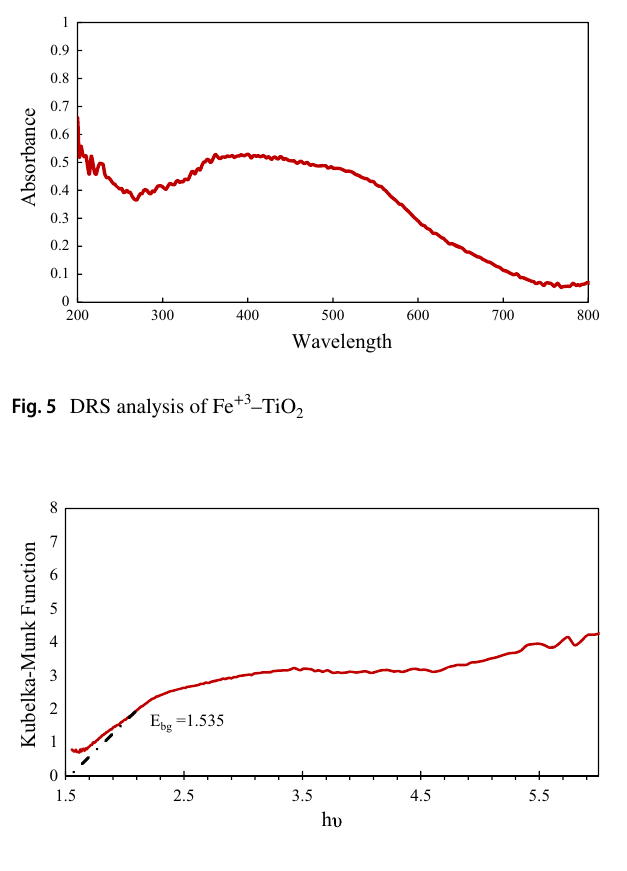
Fig. 4 XRD pattern of pure TiO